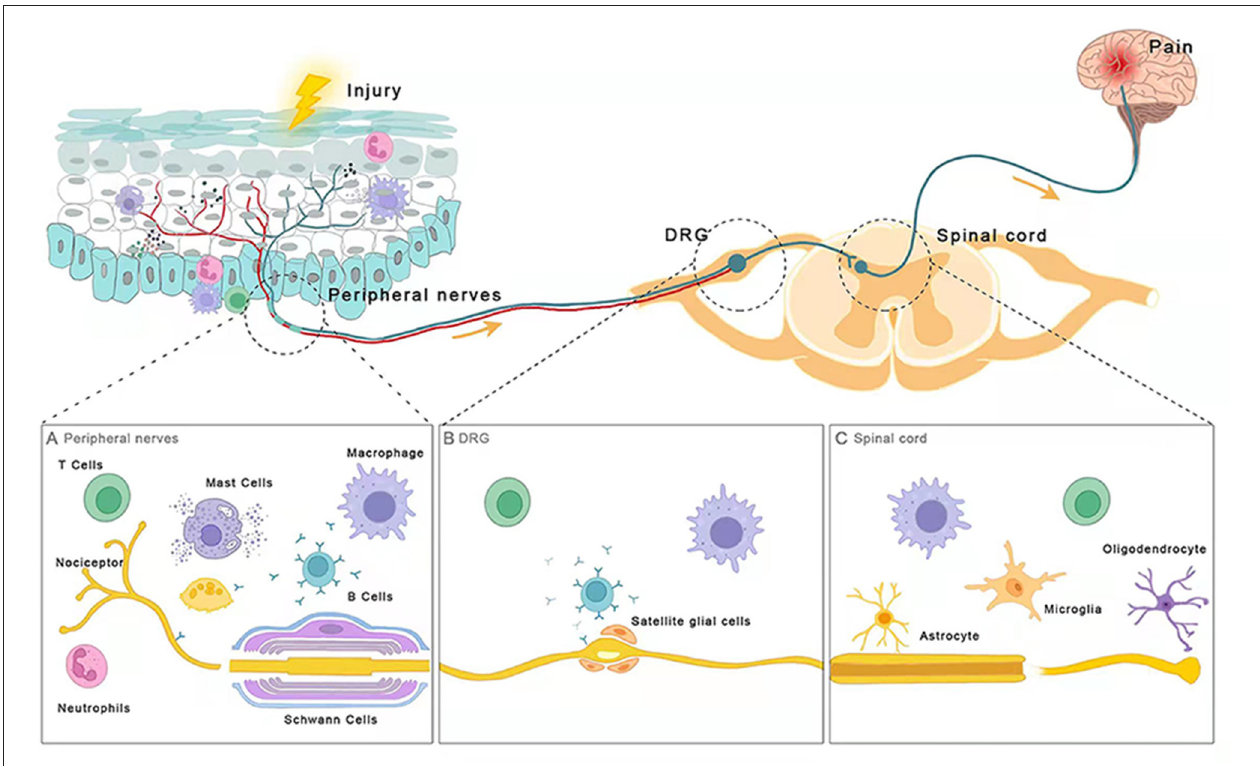
FIGURE 1 | Immune cells are involved in chronic pain. (A) Peripheral nerves (B) DRG (C) Spinal cord. After injury, distinct parts of the nociceptive pathway interact with different types of immune cells including intrinsic immune cells (macrophages, neutrophils, and mast cells), adaptive immune cells (B and T lymphocytes), and glial cells (oligodendrocytes, and astrocytes, microglia). These immune cells release neuromodulators near nociceptors and sensory neurons to modulate their sensitivity and excitability, promoting or dampening chronic pain.